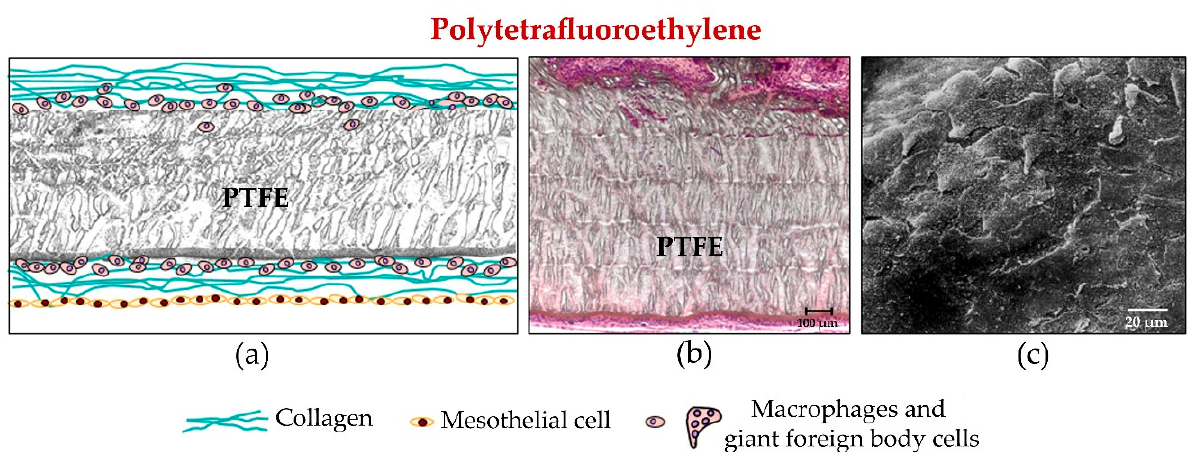
Figure 2. ( a ) Diagram and ( b ) light microscopy (90 days post-implant, 100×) images showing tissue incorporation (cross-section), in PTFE meshes, once implanted in the abdominal wall. Meshes are encapsulated by vascularized connective tissue arranged as fibrous bundles running parallel to the prosthetic surface. Cells are observed inside the biomaterial, although they fail to penetrate beyond the outer third of the laminar sheet. Scale bar: 100 µ m. ( c ) Scanning electron microscopy view of mesothelial covering (14 days, 500×). Scale bar: 20 μ m.